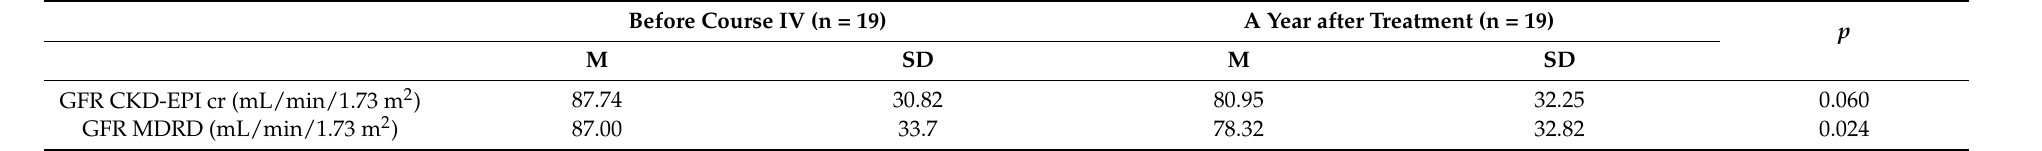
Table 7. GFR calculation using different methods of estimation.